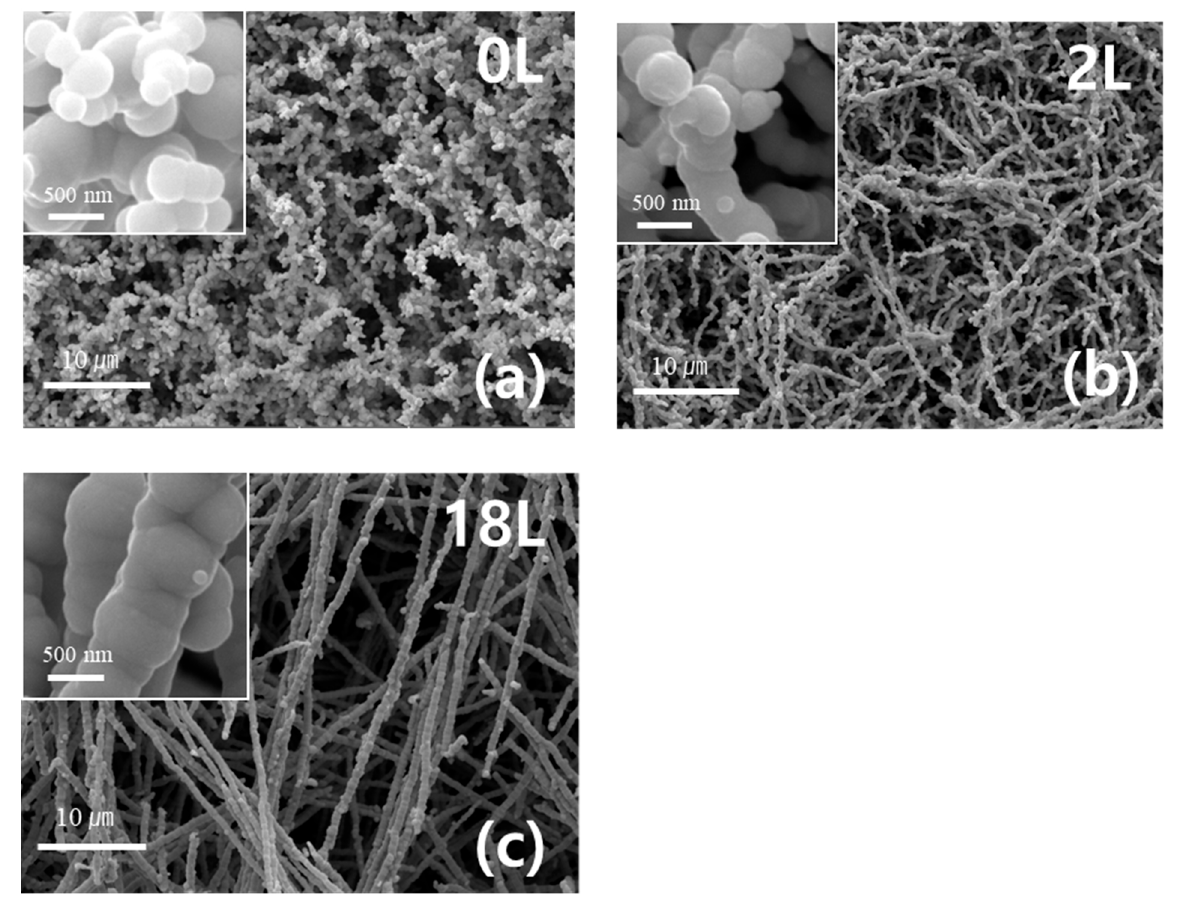
Figure 1. Scanning electron micrographs of the nickel phosphide nanowires prepared at different values of magnetic field strength: ( a ) sample 0L, ( b ) sample 2L, and ( c ) sample 18L in Table 1. Inset figures are the magnified images.